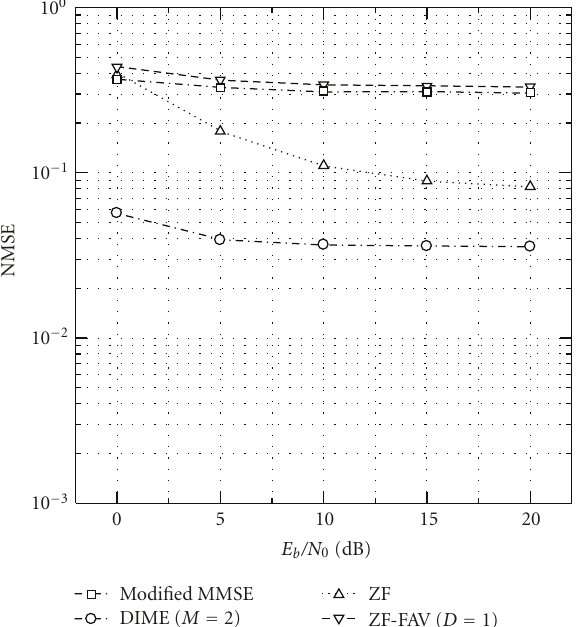
Figure 7: BER performance with 64-QAM-OFDM.